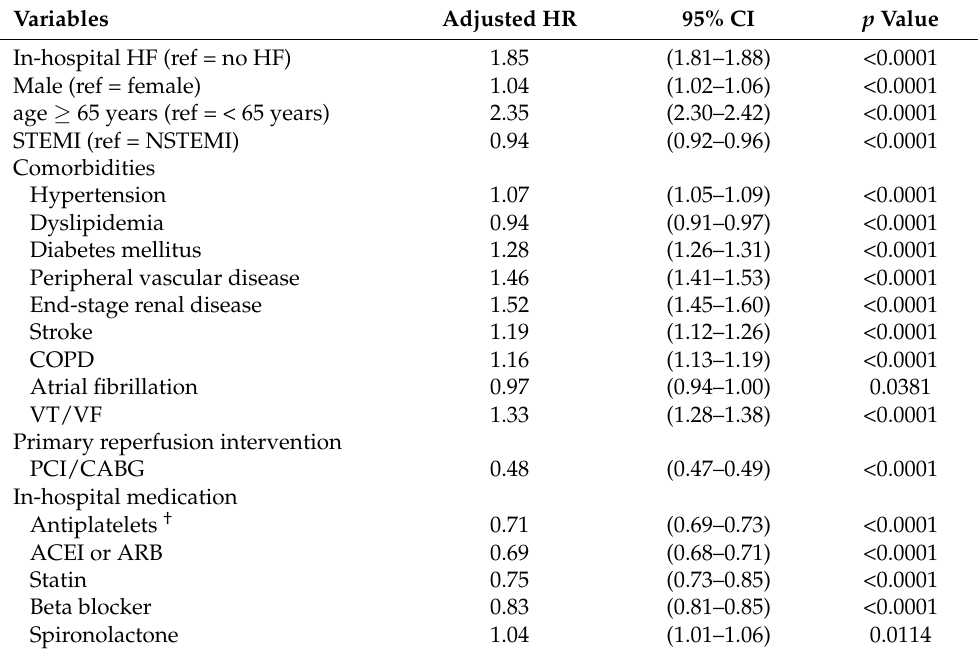
Figure 2. Kaplan–Meier curve presents long-term survival of the patients with or without HF after the first attack of AMI. Table 2. Association between basic characteristics and mortality for acute myocardial infarction patients using multivariate Cox proportional hazard regression analyses (n = 76,184).